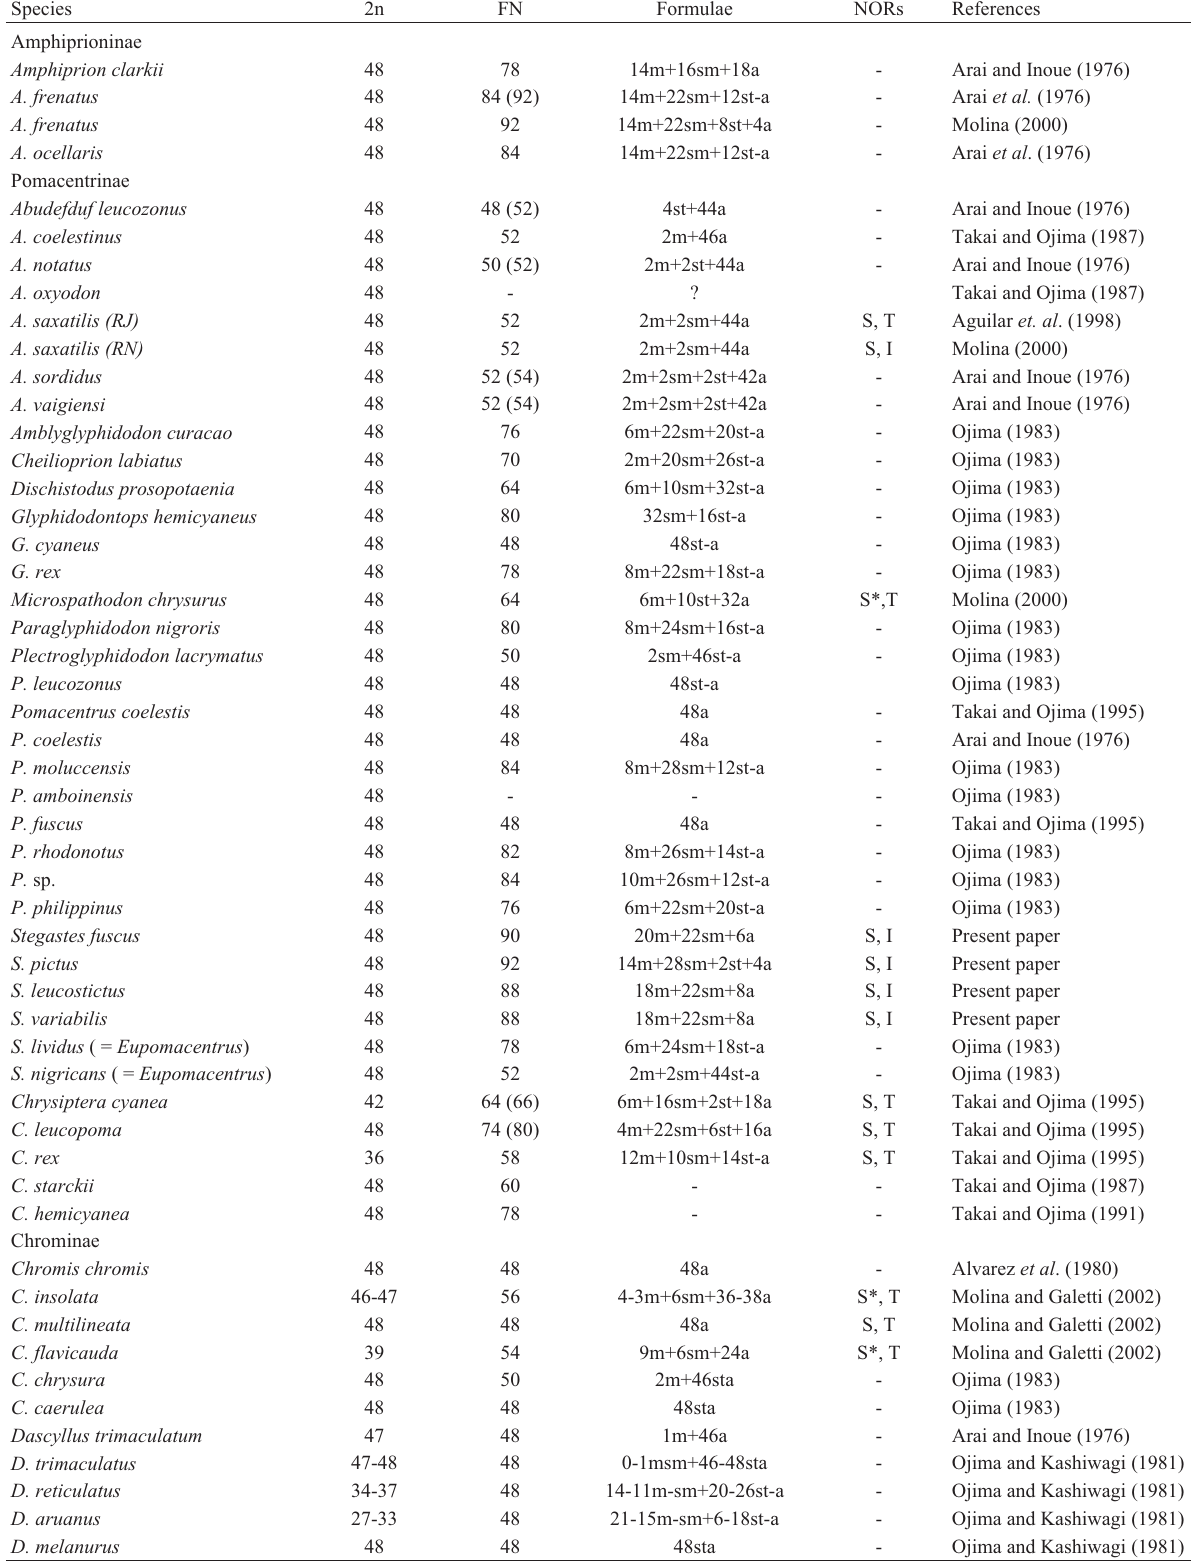
Table 1 - Chromosome numbers in the family